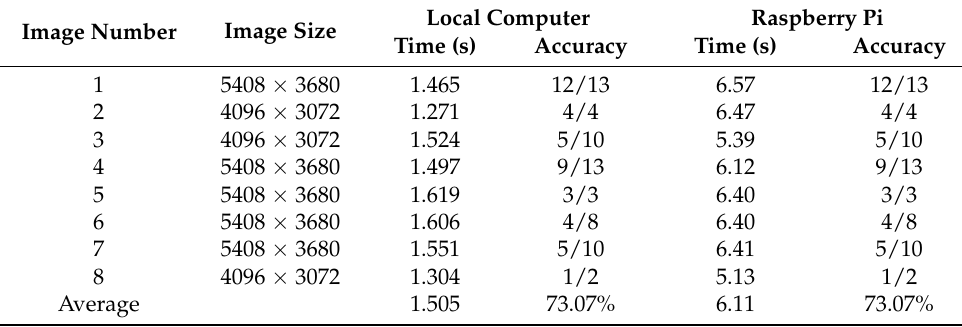
Table 3. Comparison of testing results on images.